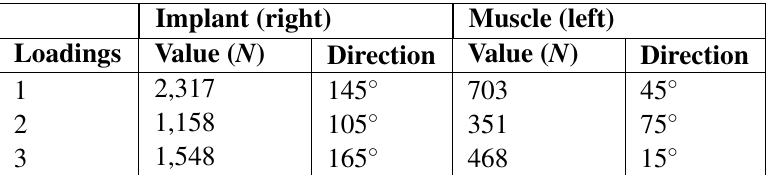
Table 2 Loading condition for the first case.